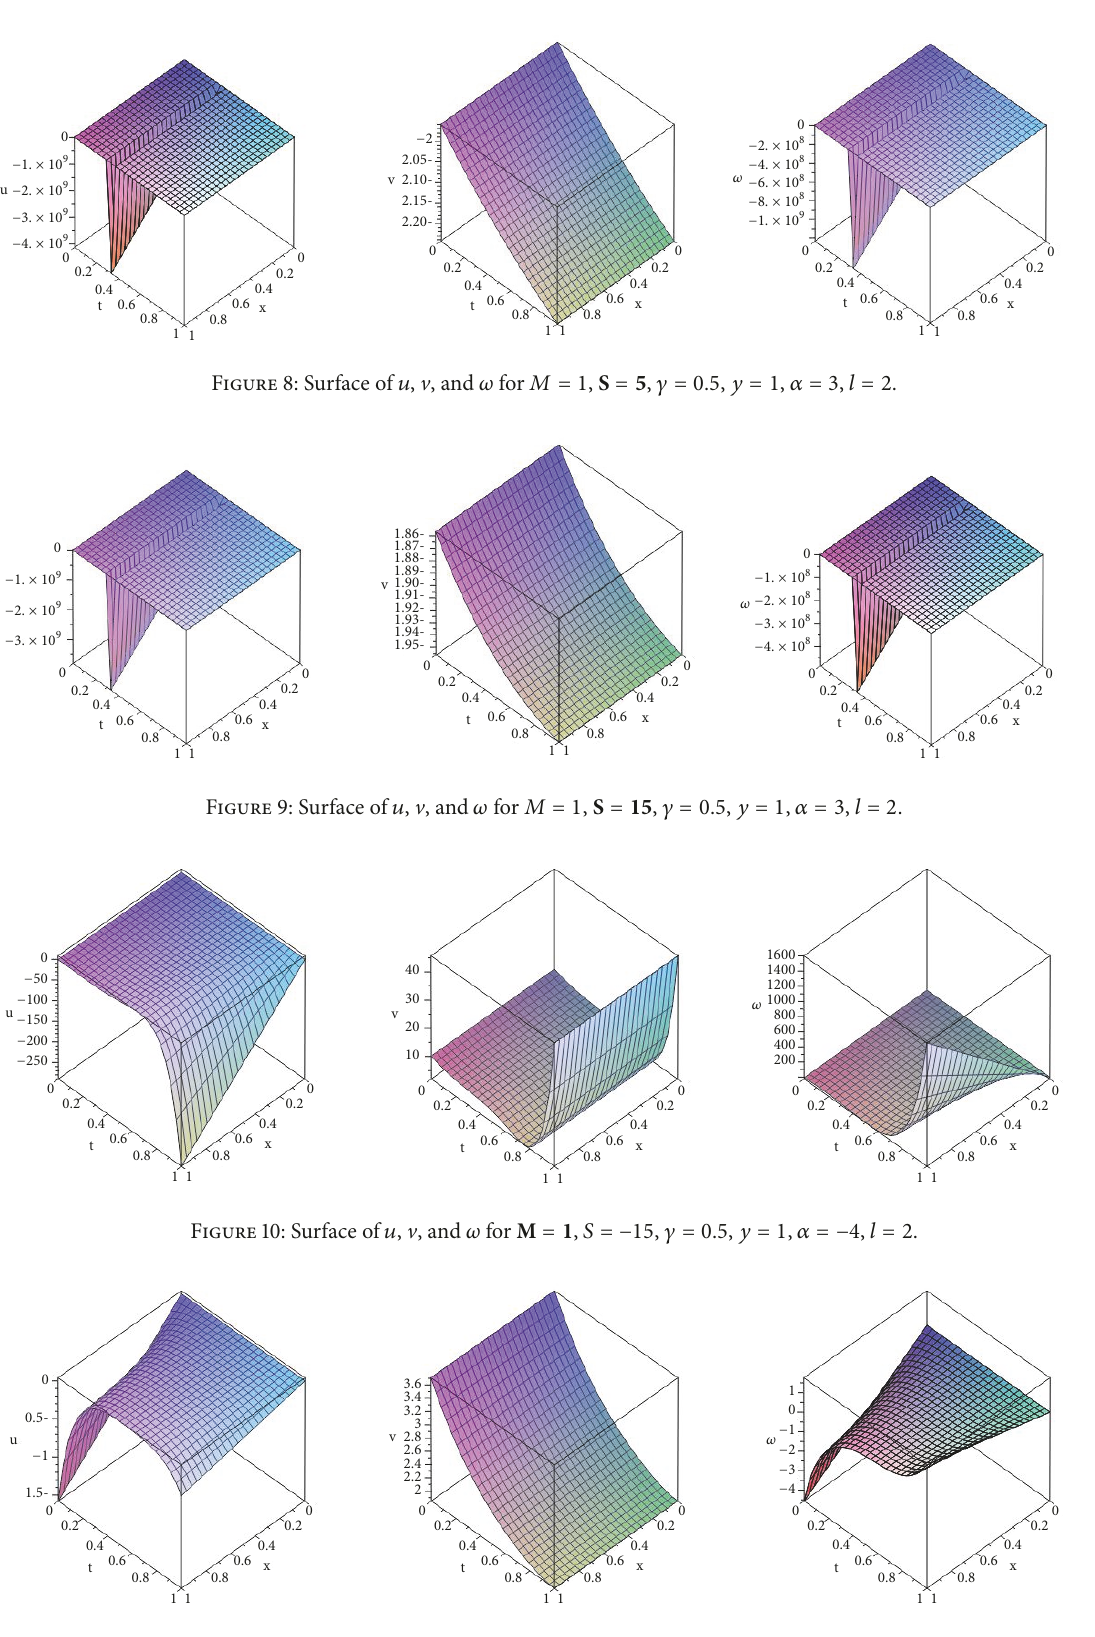
Figure 11: Surface of 𝑢 , V , and 𝜔 for M = 4 , 𝑆 = −15 , 𝛾 = 0.5 , 𝑦 = 1 , 𝛼 = −4 , 𝑙 = 2